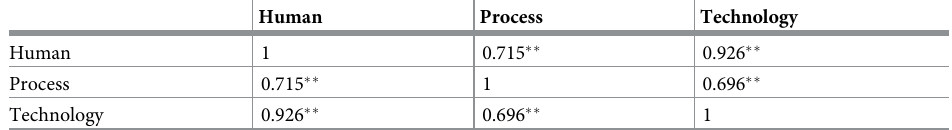
Table 16. Correlation test between human, process, and technology factors.